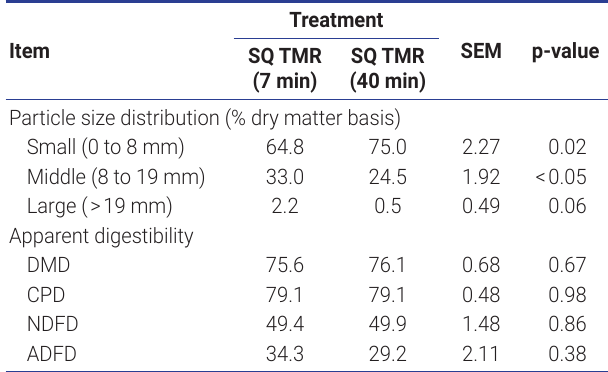
dium particles (8 to 19 mm; 7 min, 33.0%; 40 min, 24.5%; p<0.05). Mixing time did not significantly affect CP (7 min, 79.1%; 40 min, 76.1%), NDF (7 min, 49.4%; 40 min, 49.9%), four animals showed an average initial weight of 474.3±28.2